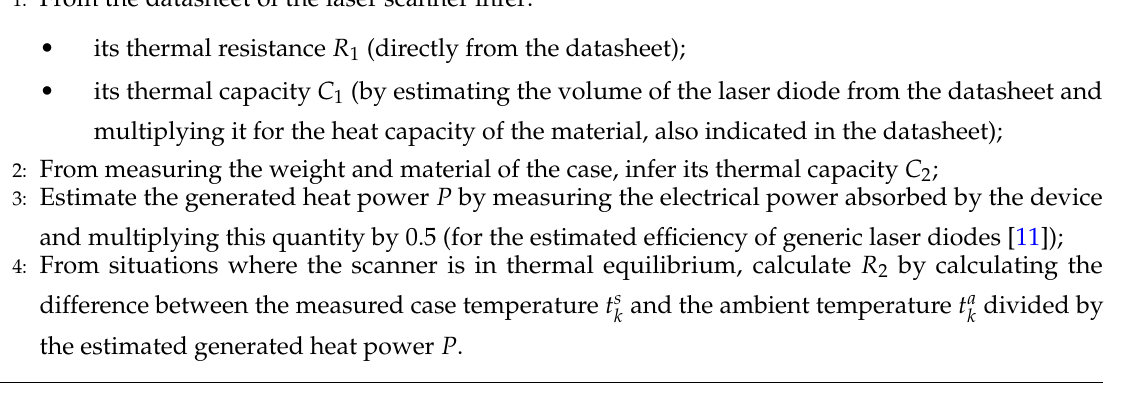
Algorithm 1 Identification of model Equation (5) starting from the datasheet of a laser